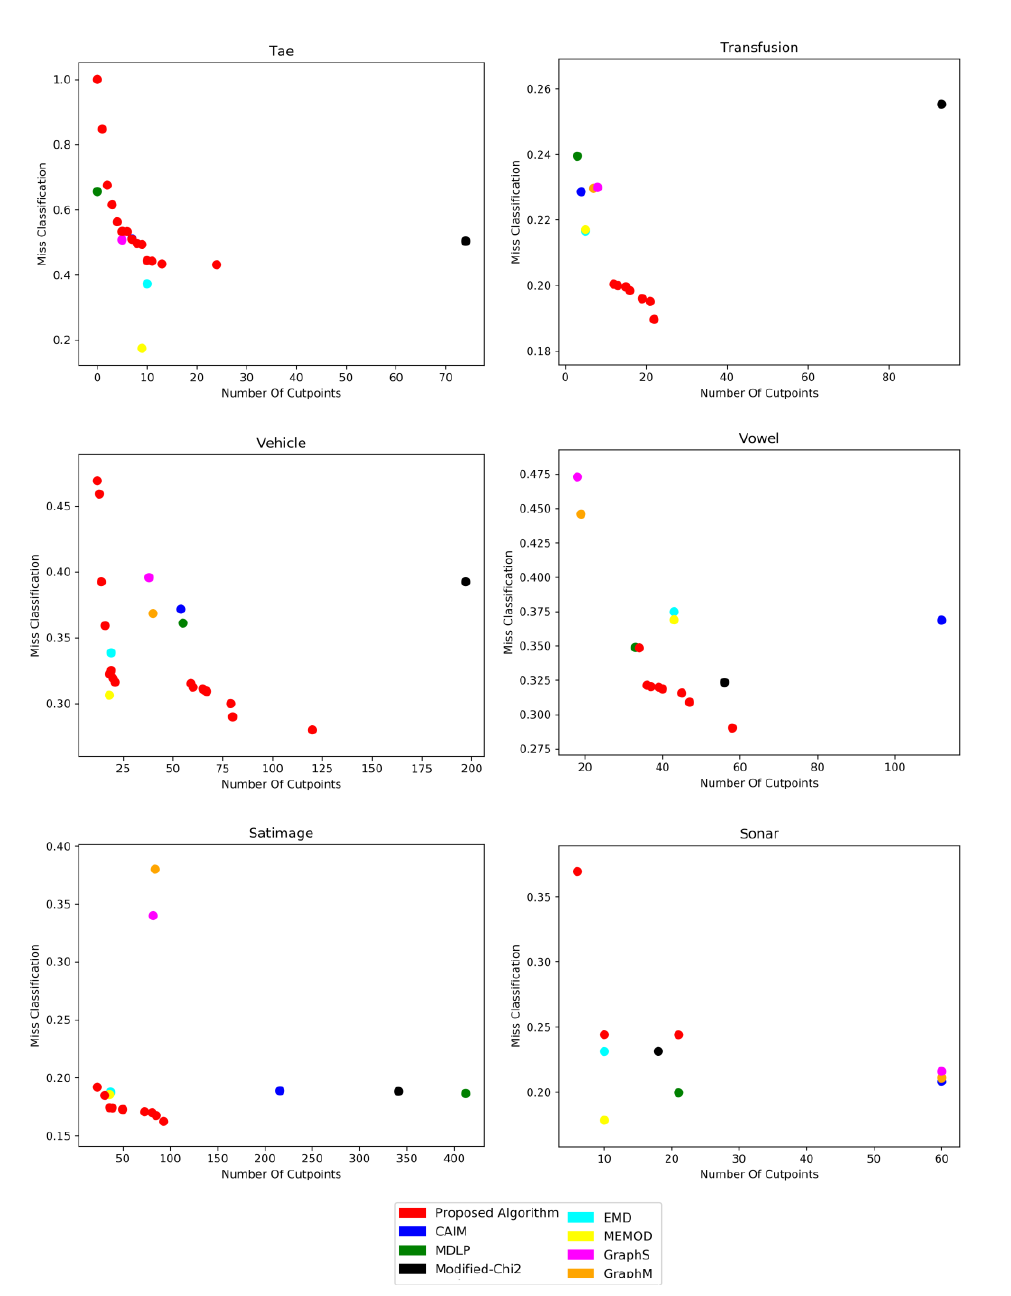
Figure 3. Projection of non-dominated solutions obtained by the proposed algorithm for the considered datasets